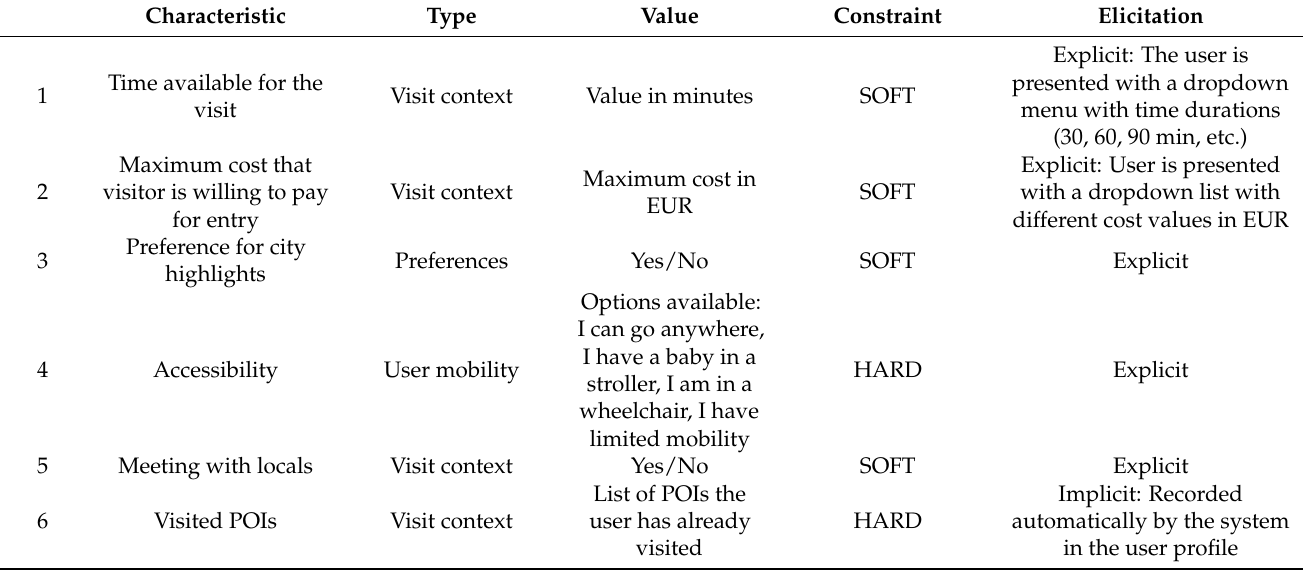
Table 2. User model.